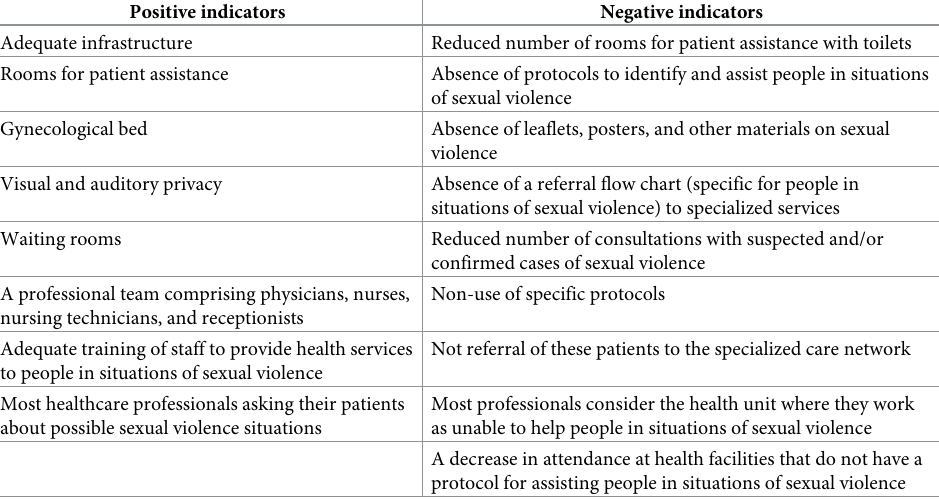
Table 3. Positive and negative indicators resulting from the evaluation of the quality of care provided to people in situations of sexual violence in health